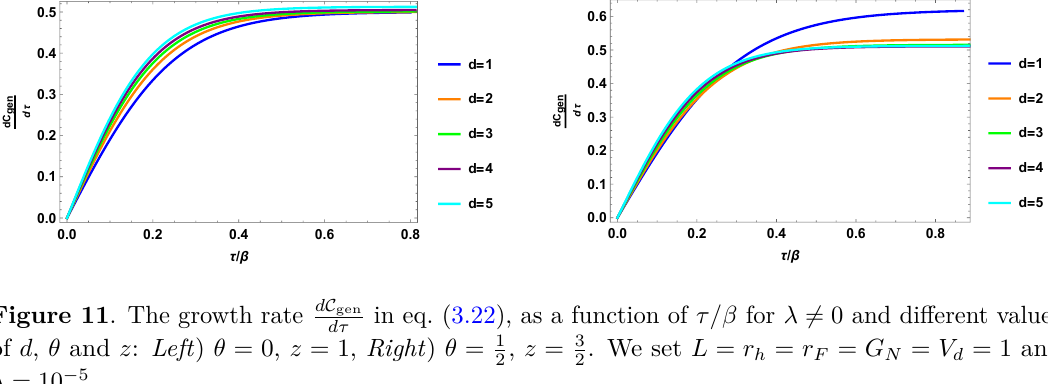
= r = G = V = 1 and h F N d